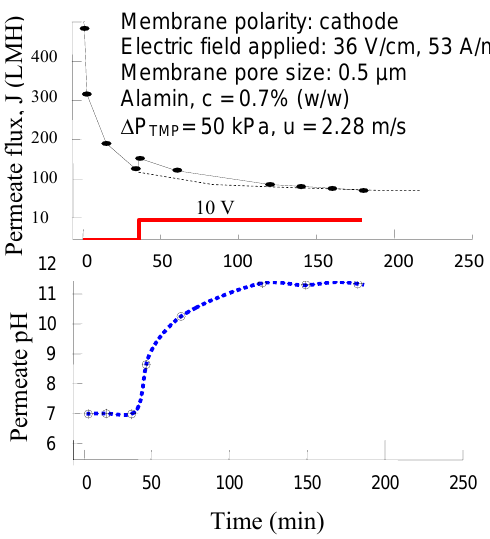
Figure 4. Influence of the electric field to the flux decline.